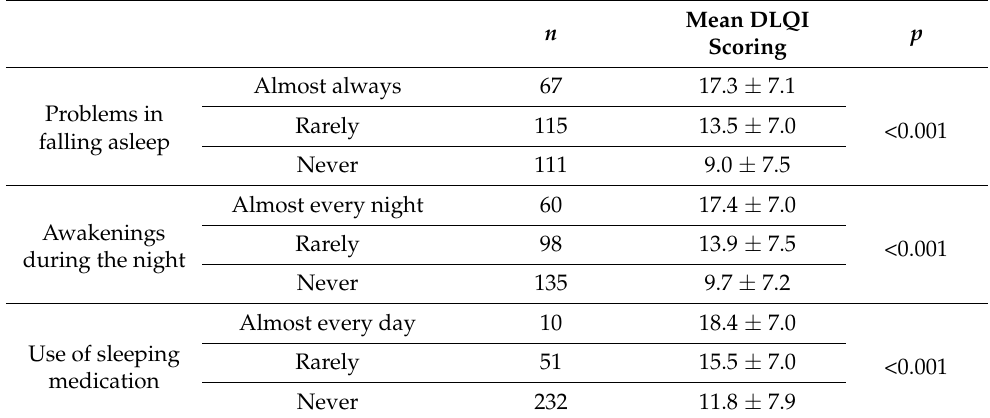
Table 3. Comparison of quality of life in relation to the sleeping problems (DLQI—Dermatology Life Quality